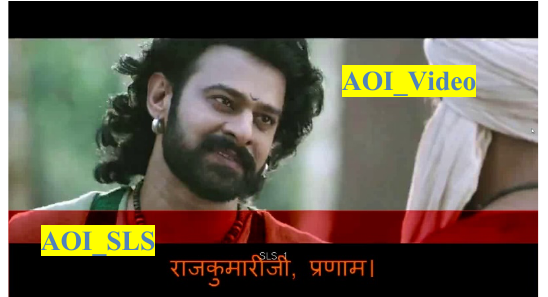
Figure 4: Video and SLS region considered as first AOI